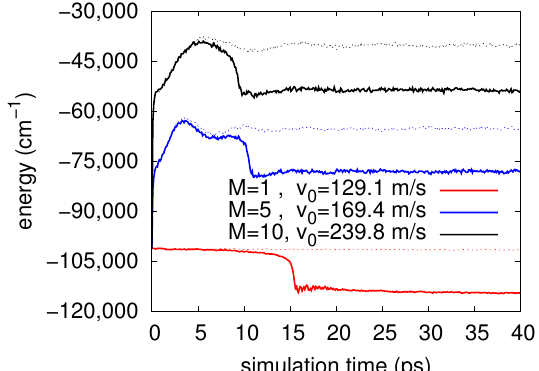
Figure 5. Time evolution of the total energy of the Cs 2 -C 60 @He 2090 system at T = 2 K, obtained in simulations performed at the indicated number of beads M . Solid lines correspond to initial relative velocities of the Cs 2 -C 60 interacting pair ( v 0 ) indicated in the figure, while dashed lines, maintaining the relation color/ M , correspond to a common initial velocity v 0 = 25.4 m/s.